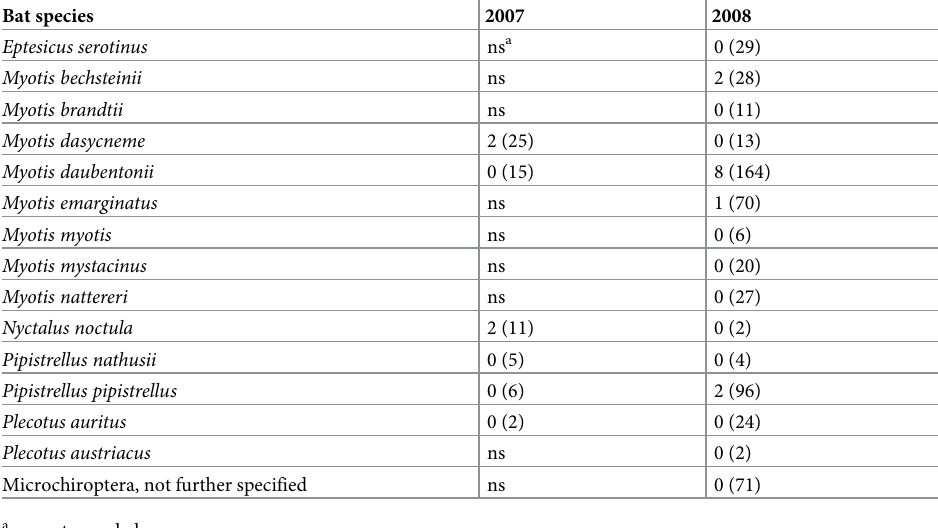
Table 1. Number of Campylobacter- positive bats (total number of bats sampled) in 2007 and 2008. Bat species